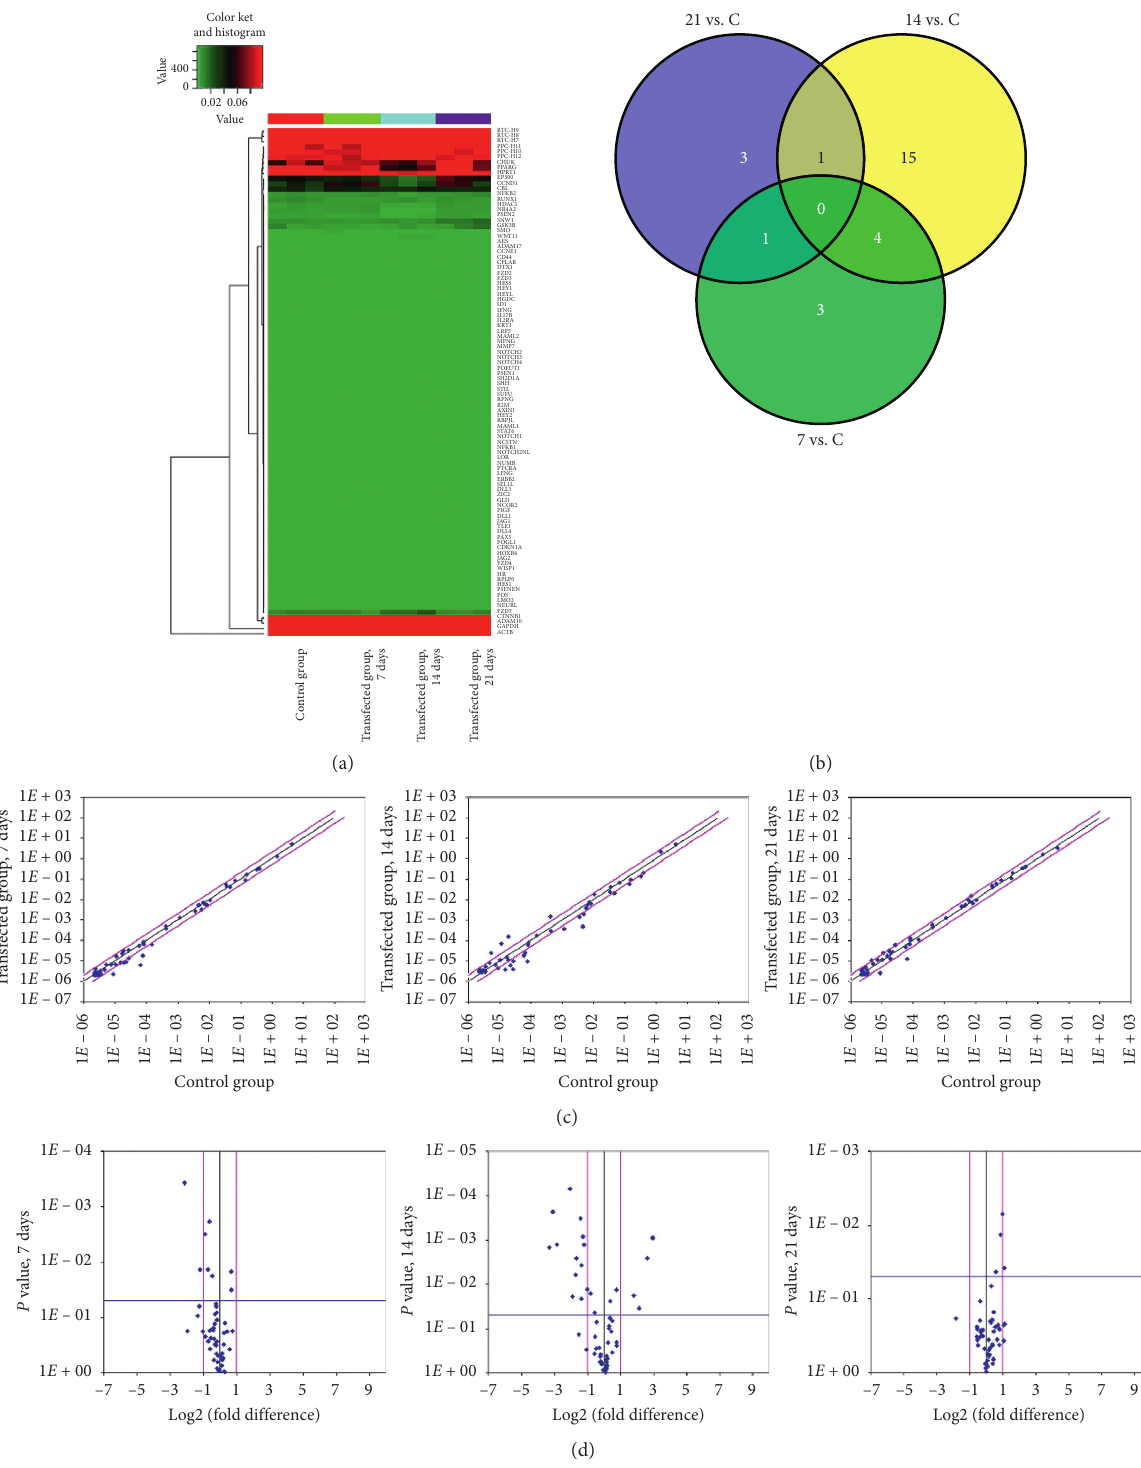
Figure 6: Differently expressed Notch-related genes between the control and transfected groups. (a) Heat maps showing significant changes in the expression of Notch-related genes between the control and transfected groups. (b) Venn diagram based on the differential expression of Notch-related genes between the two groups. (c) Scatter plots showing the differentially expressed Notch-related genes in the control group and transfection group. (d) Volcanic diagram showing the number of differentially expressed Notch-related